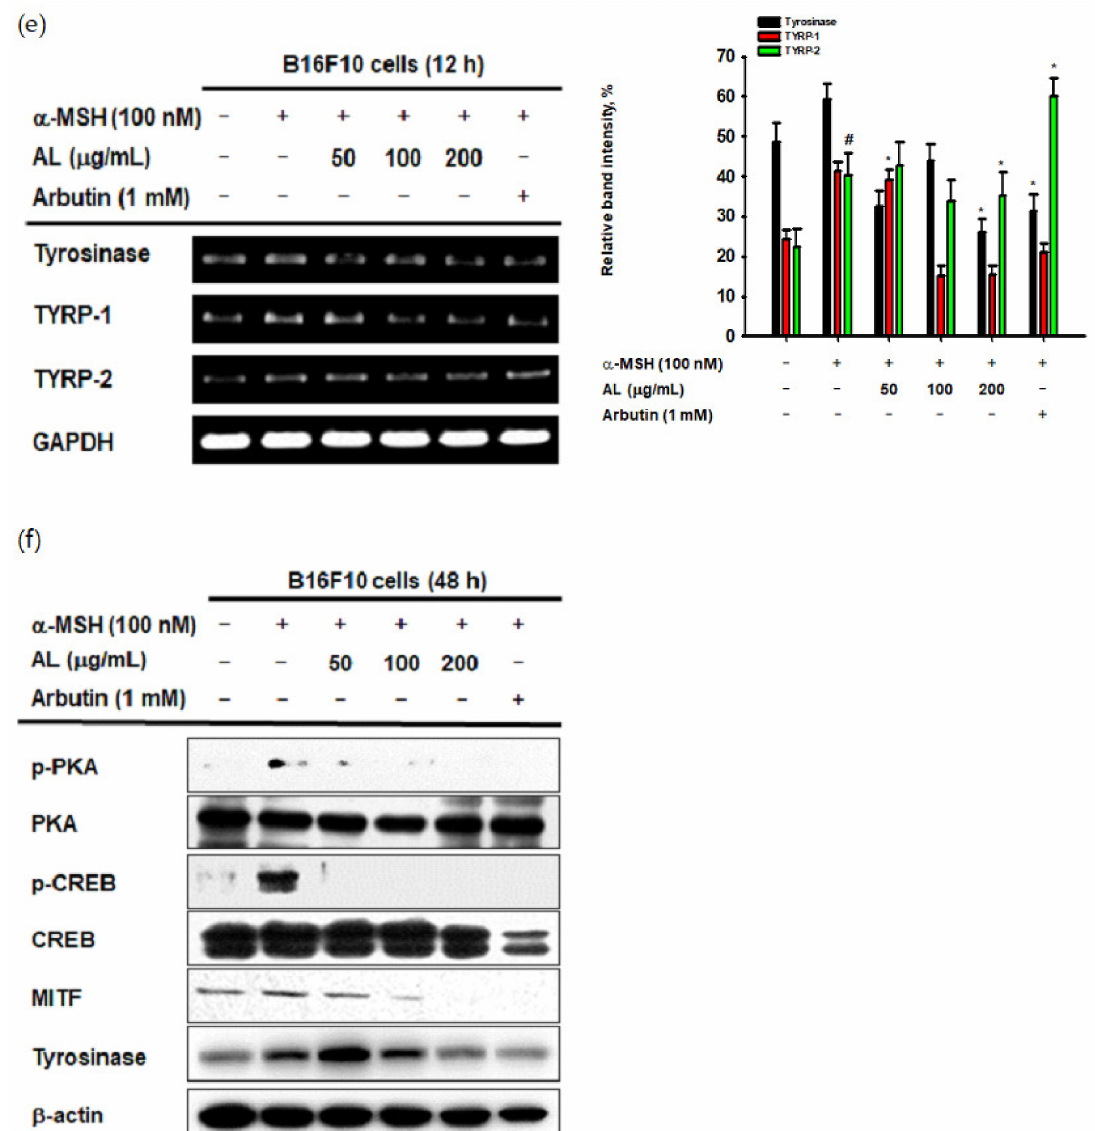
Figure 4. Antimelanogenesis e ff ects of AL in B16F10 cells. ( a ) The viability of murine melanoma (B16F10) cells treated with the indicated dose of AL (50–200 µ g / mL) for 48 h was measured using the MTT assay. B16F10 cells were treated with AL (50–200 µ g / mL) or arbutin (1 mM) for 48 h, and melanin secretion and intracellular melanin were measured at 475 ( b ) and 405 nm ( c ), respectively. ( d ) Tyrosinase activity was measured in response to the indicated dose of AL (50–200 µ g / mL) or kojic acid (300 mM). ( e ) The mRNA expression of tyrosinase, TYRP1, and TYRP-2 in B16F10 cells treated with AL (50–200 µ g / mL) or arbutin (1 mM) were determined using PCR analysis. ( f ) Protein expression levels of various cyclic adenosine monophosphate (cAMP) signaling pathway proteins in response to AL (50–200 µ g / mL) or arbutin (1 mM) were determined using Western blotting. + : indicate treatment, -: indicate non-treatment. For all applicable experiments, statistical significance was evaluated using the Mann–Whitney U test. # p < 0.05 and ## p < 0.01 compared with the normal group, * p < 0.05 compared with the control group, ** p < 0.01 compared with the control